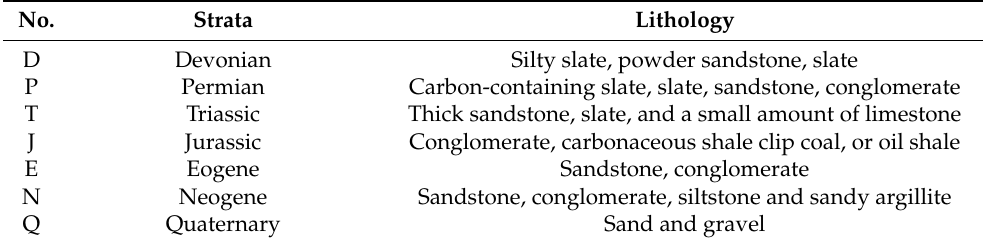
Table 2. Descriptions of lithologic characteristics and strata in the Minxian area